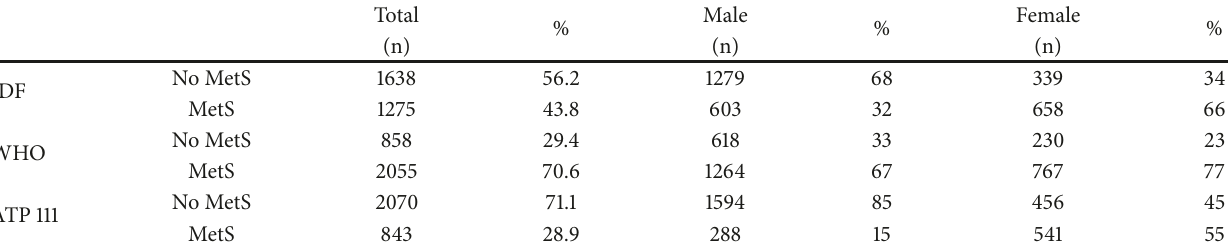
Table 3: Prevalence of metabolic syndrome according to the three different criteria and gender.